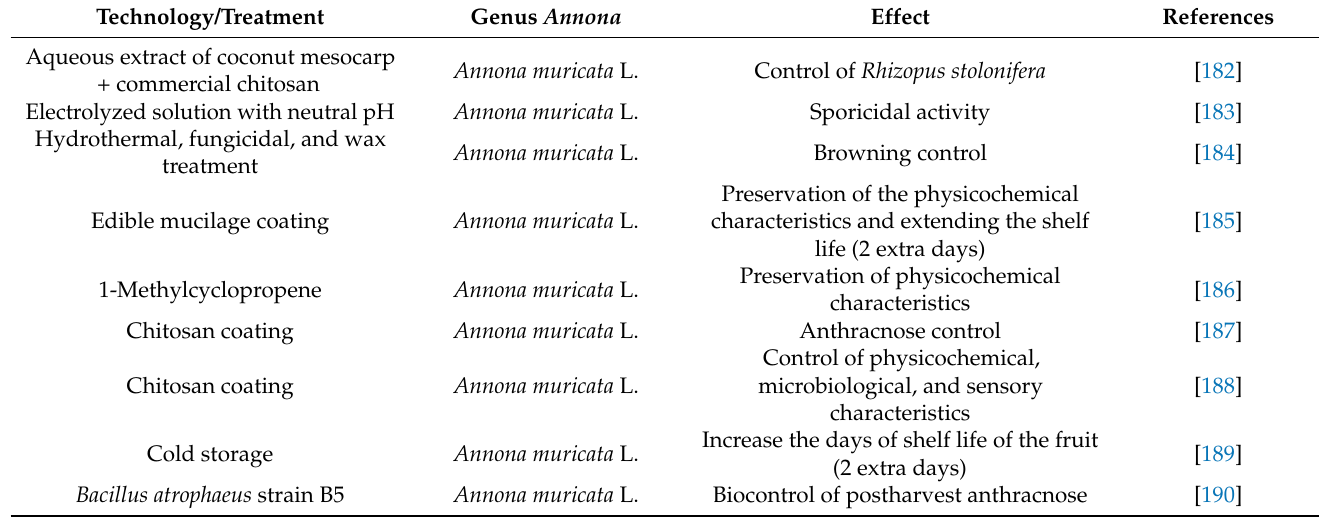
Table 5. Postharvest technologies or treatments to extend the shelf life of fruit of the genus Annona . Technology/Treatment Genus